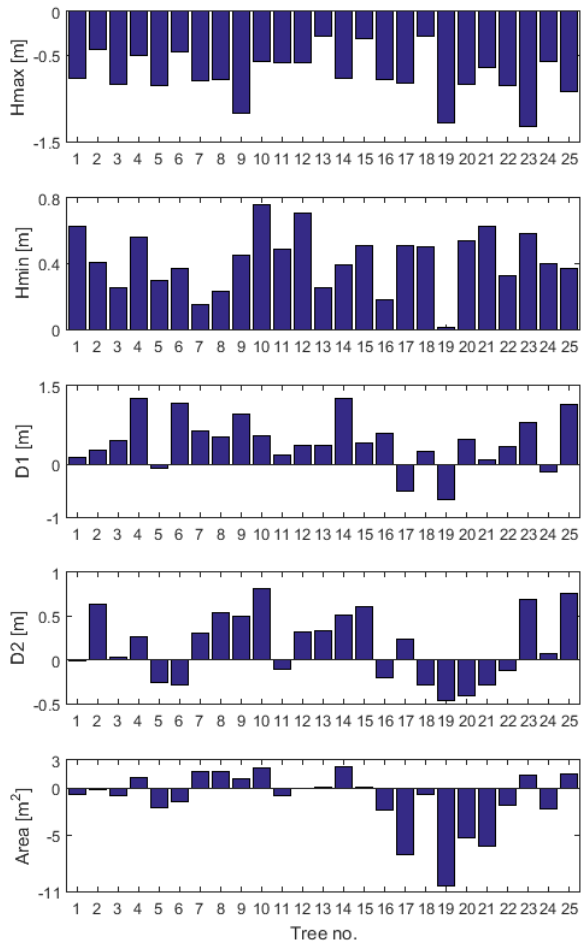
Figure 4. Differences between estimated tree geometric parameters and field